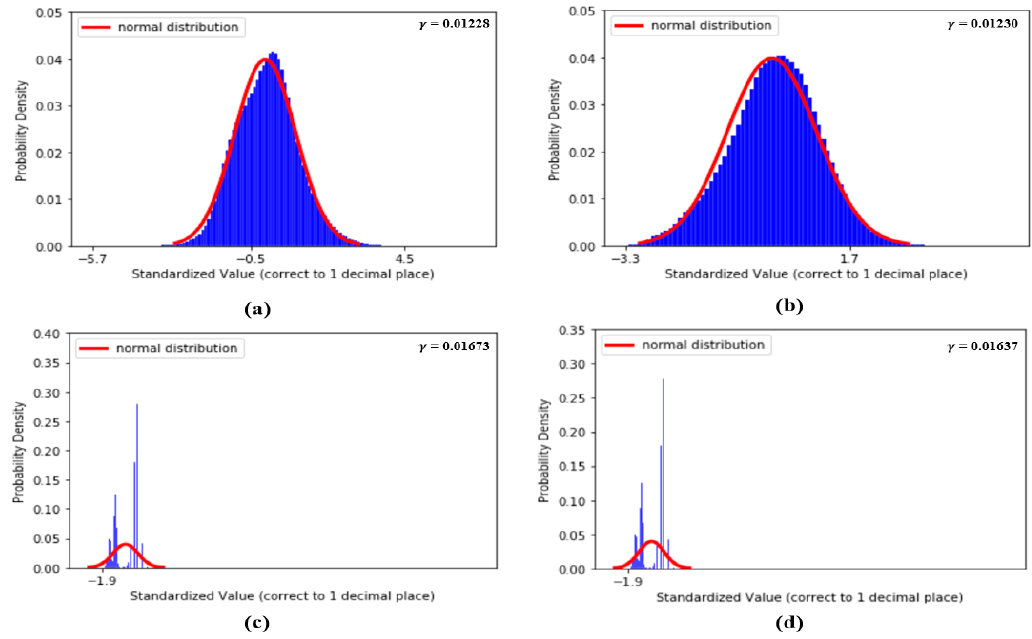
Figure 9. ( a ) Distribution of dDA , ( b ) distribution of NI , ( c ) distribution of sdAT and ( d ) distribution of t7.